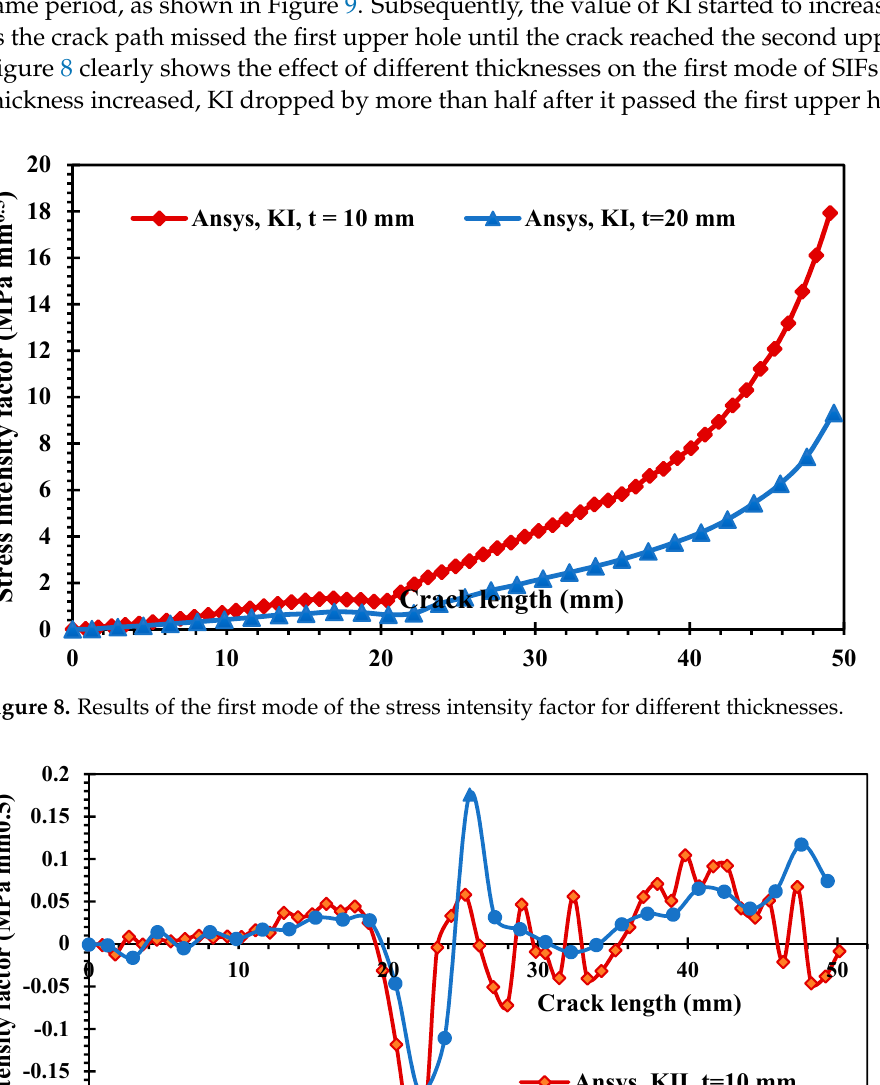
Figure 9. Results of the second mode of the stress intensity factor for different thicknesses.